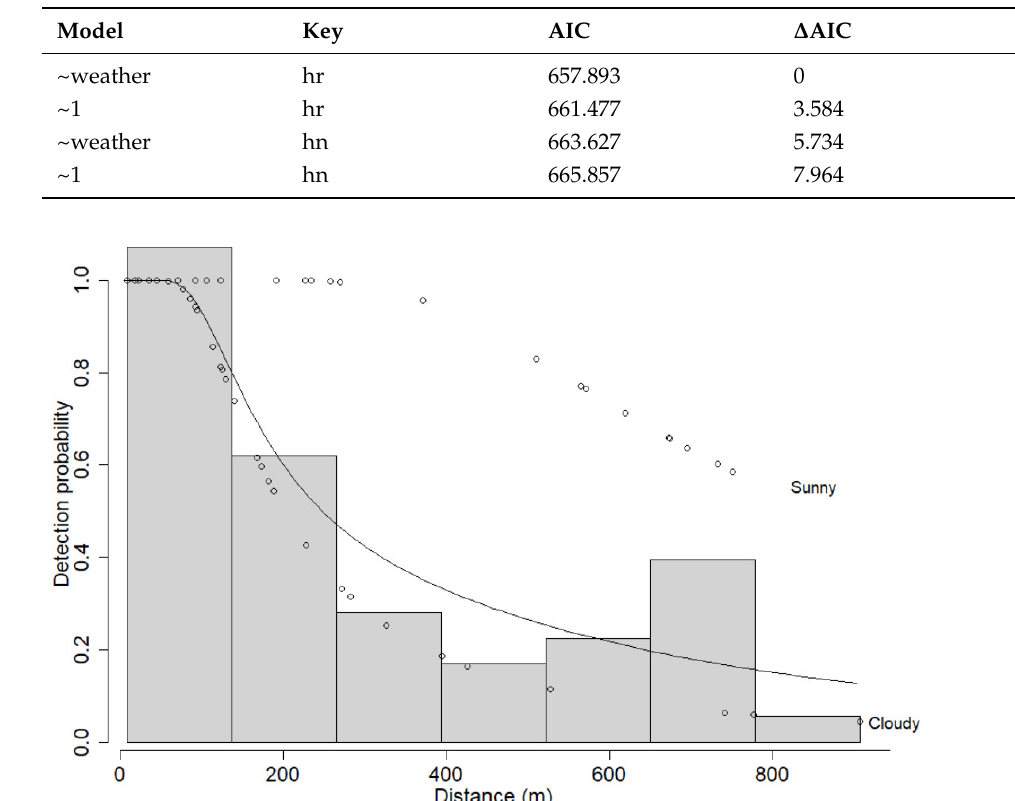
Table A2. The four candidate detection probability models for Distance sampling (DS) of Sval- bard reindeer, Svalbard, Norway (July 2021). Detection probability was fitted using half-normal (hn) and hazard rate (hr) functions with weather (sunny or cloudy) as covariate (see Table S3 in Le Moullec et al. [22] for the influence of other covariates). We ranked models using Akaike’s Information Criterion (AIC) and differences in AIC ( ∆ AIC).